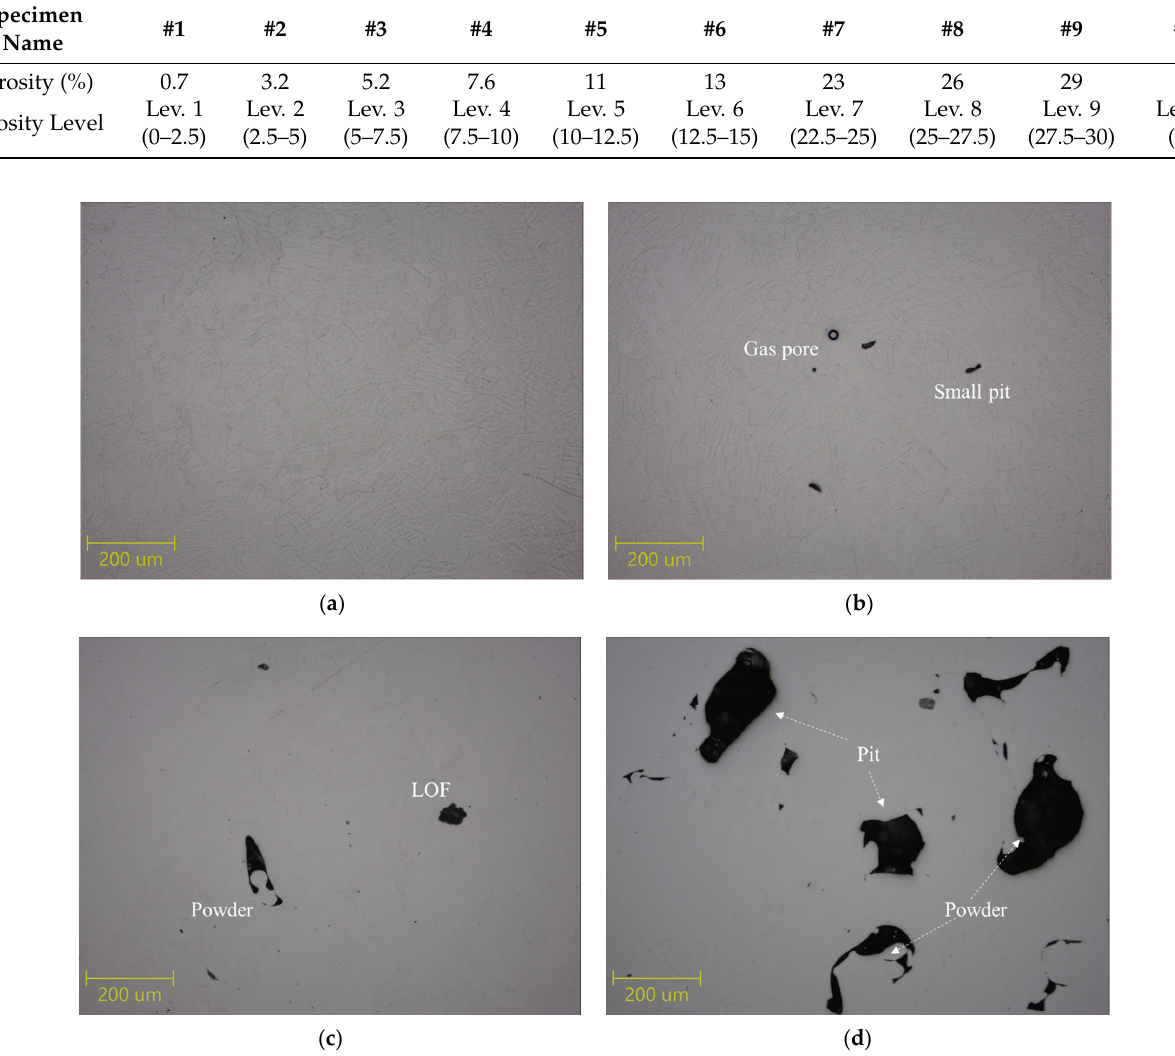
Figure 2. C-scan images obtained from specimens #1 to #10. Table 3. Porosity content of specimens #1 to #10 as measured using scanning acoustic microscopy (SAM), and the corresponding porosity levels.